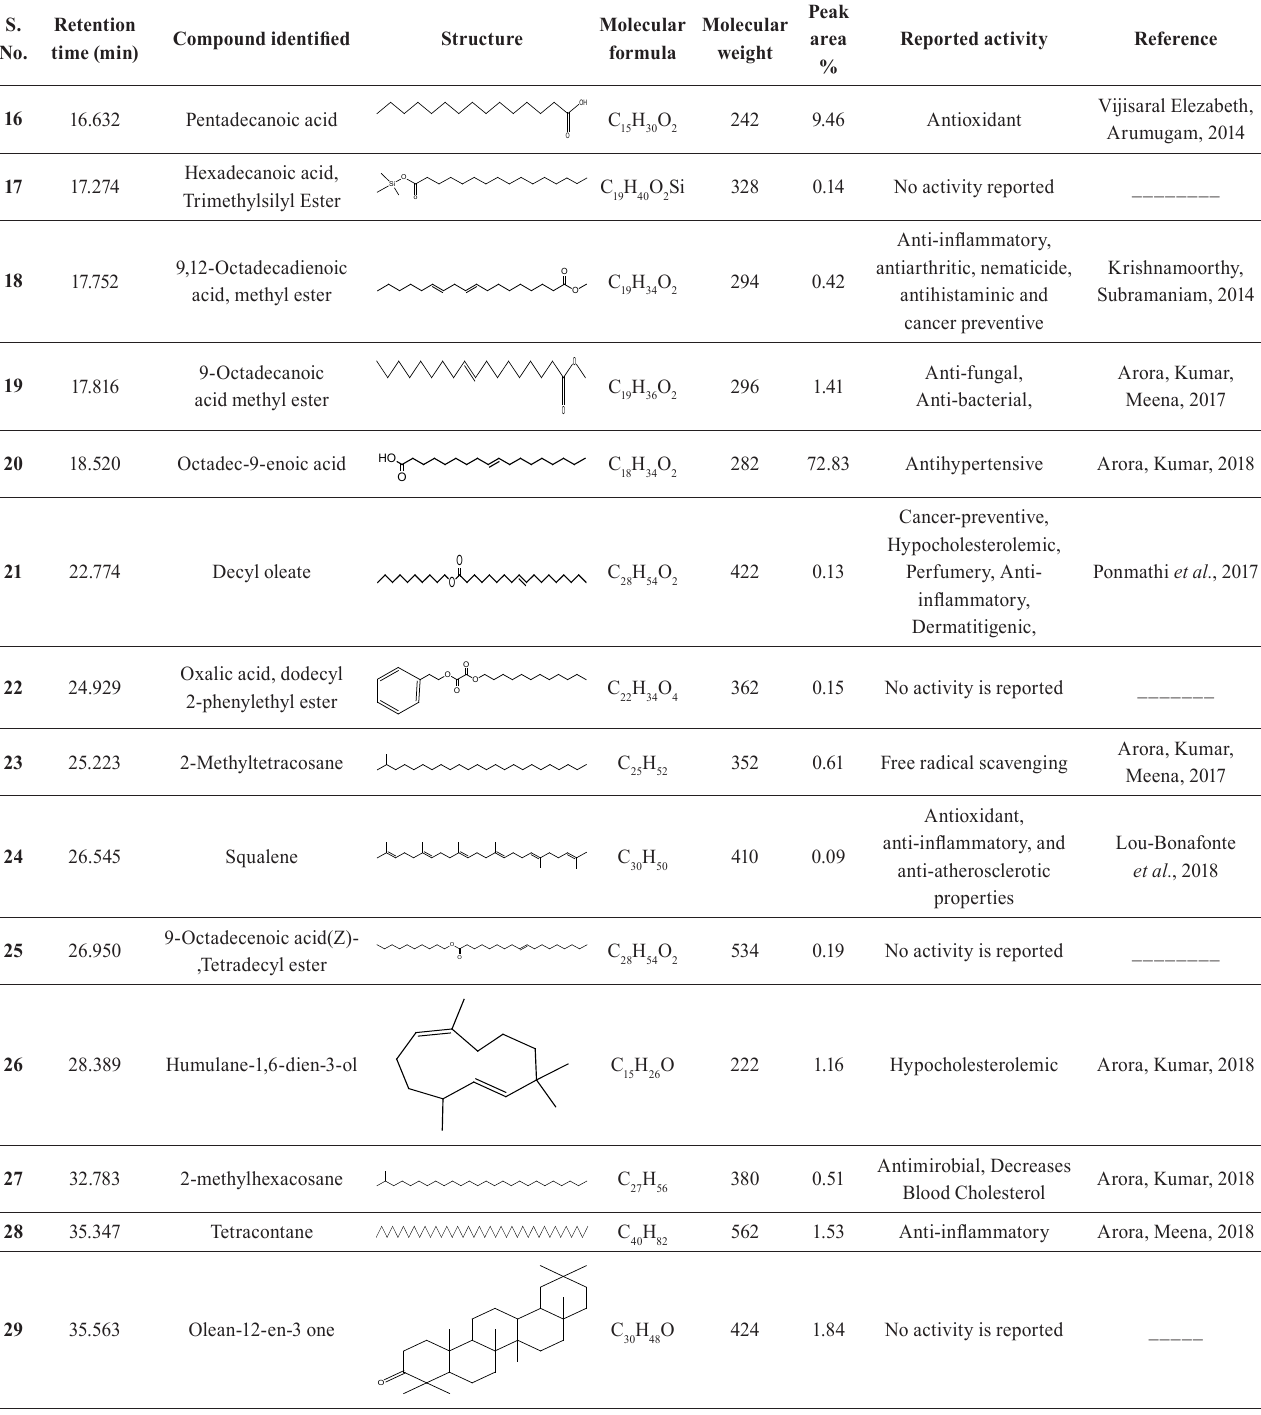
TABLE IV - List of phytocomponents identified by Gas Chromatography Mass Spectrometry (GC-MS) analysis of EAE of N. arbor- tristis L. seed and their bioactivity